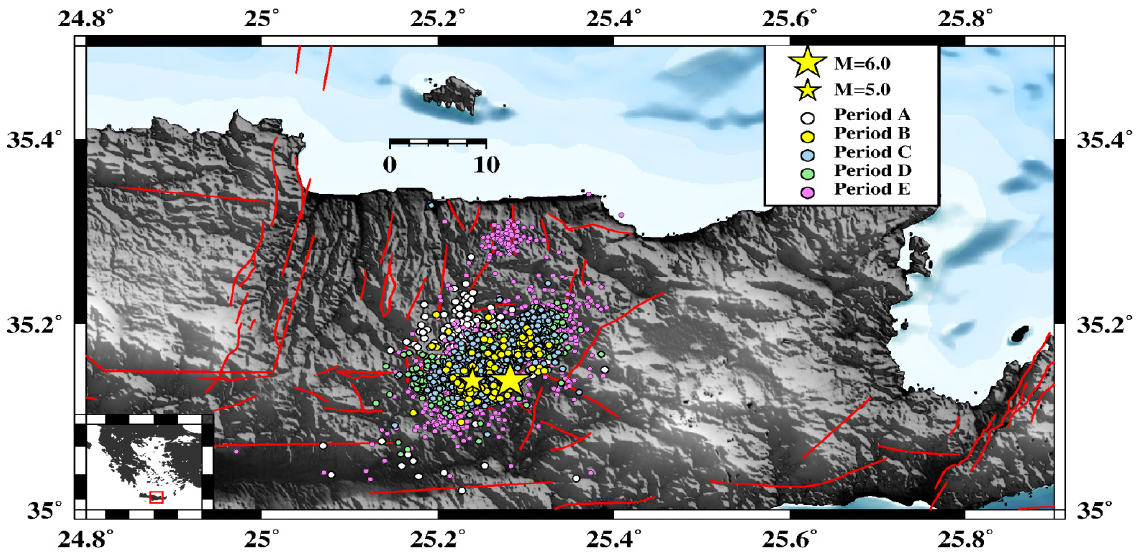
Figure 3. Temporal distribution of the 2021–2022 Arkalochori sequence for 4750 events. Periods A, B, C, D, and E are marked with orange, yellow, green, purple, and violet circles, respectively. The M ≥ 4.0 earthquakes are depicted by yellow stars. Faults are marked as red lines (see text for details).